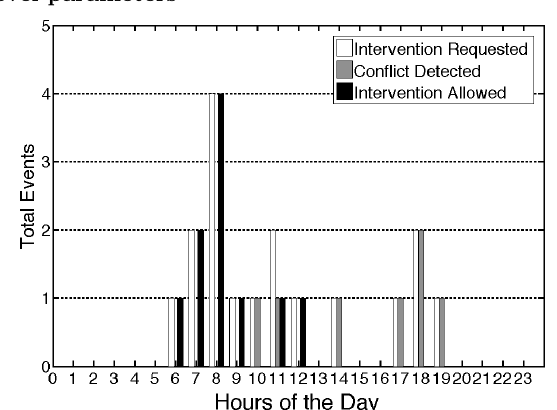
Figure 4: Installation time conflict detection on high level parameters